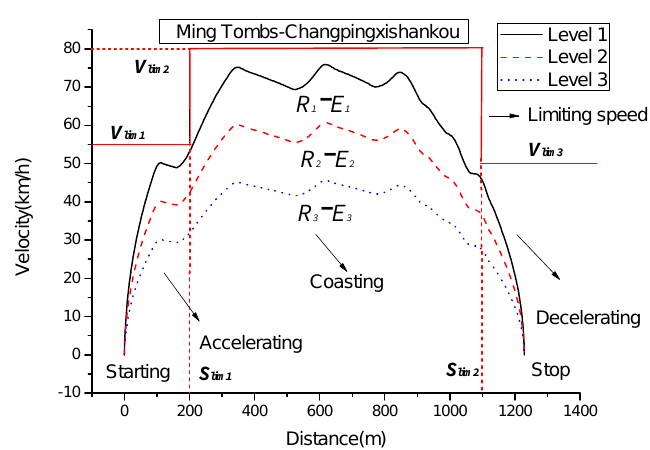
Figure 6. Different profiles with different